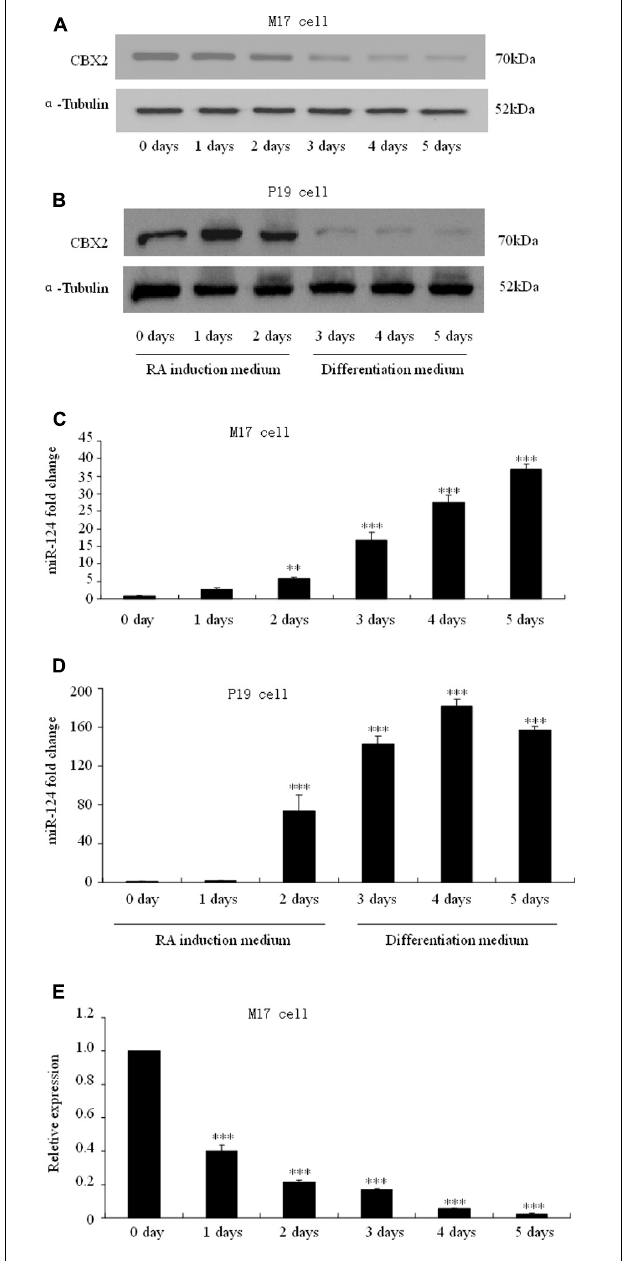
FIGURE 2 | CBX2 and miR-124 expressions are inversely correlated during neuronal differentiation. The immunoblotting analysis is shown of CBX2 expression during human M17 cell (A) and mouse P19 cell (B) neuronal differentiation. Real-time polymerase chain reaction (PCR) analysis of miR-124 expression during neuronal differentiation of human M17 cells (C) and mouse P19 cells (D) is shown. (E) RT-qPCR analysis of CBX2 mRNA expression during M17 cells neuronal differentiation. The data are presented as the mean ± SD, n = 3 independent experiments, ∗∗ P < 0.01, ∗∗∗ P < 0.001.